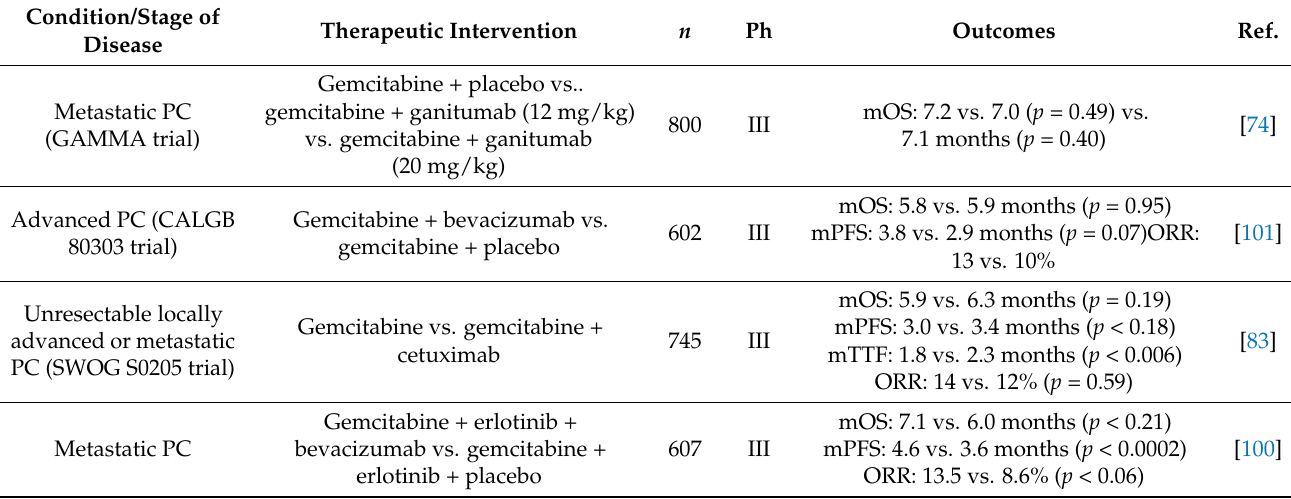
Table 5. Phase III clinical trials of monoclonal antibodies alone or in combination with other drugs for pancreatic cancer treatment (www.clinicaltrials.gov accessed on 17 March 2021).